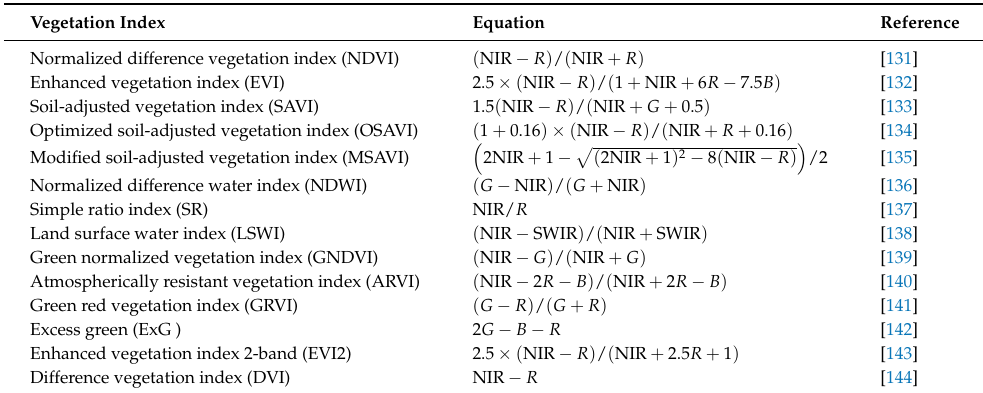
Table A2. List of RGB and multispectral-based vegetation